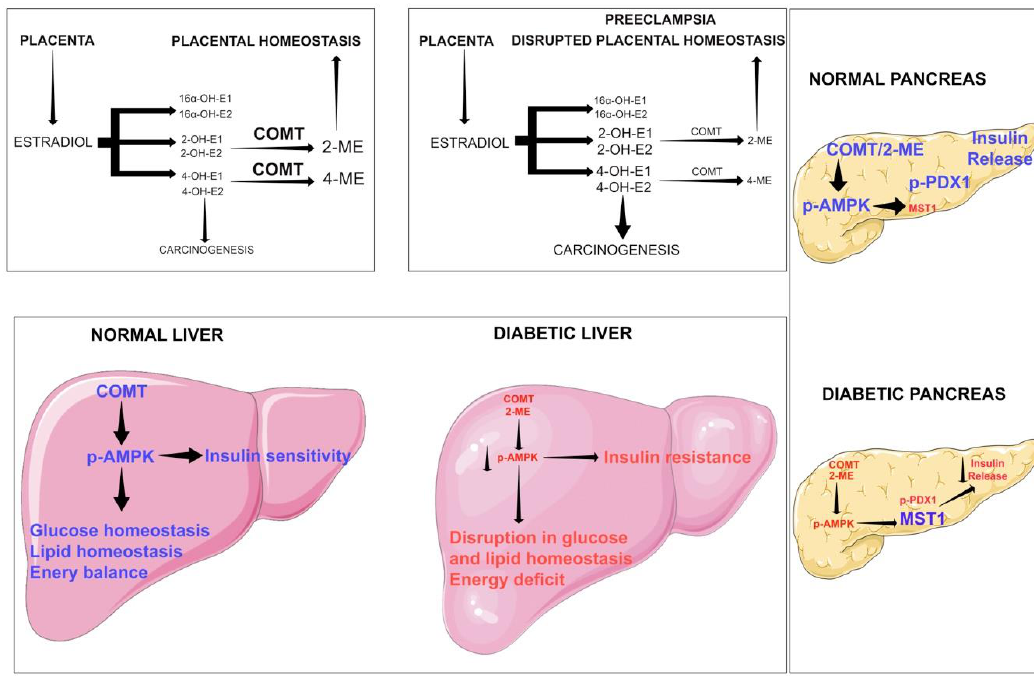
Figure 3. Significance of COMT in regulating metabolic homeostasis. Catechol- o -methyltransferase (COMT) is an enzyme that transmethylates hydroxyestradiol into 2-methoxyestradiol (2-ME). 2-ME is protective in maintaining placental homeostasis and metabolic homeostasis through insulin release from pancreatic β -cells. COMT/2-ME phosphorylates liver AMPK which is linked to glucose homeostasis. COMT/2ME is suppressed in the diabetic liver and is linked to a disruption in glucose homeostasis. In pancreatic β -cells, COMT/2ME is an essential protein for PDX1 phosphorylation and is associated with insulin release. In diabetic conditions, low levels of COMT/2ME repress PDX1 phosphorylation and induce MST1. Activated MST1 leads to β -cell death and is responsible for a reduction in insulin release. Cumulatively, COMT is an essential protein that regulates metabolic insults. Deficiency of COMT results in low levels of 2-ME and the accumulation of 4-hydroxyoestradiol (4-OH-E1 and 4-OH-E2). 4-OH-E1 and 4-OH-E2 are believed to possess malignant properties in several organs.